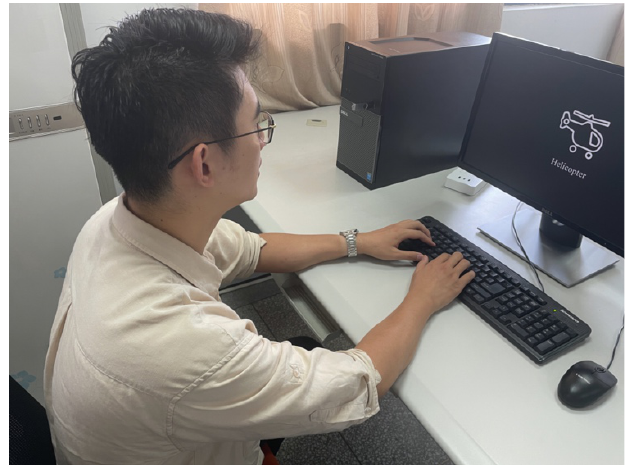
Figure 3. Experimental scene image.